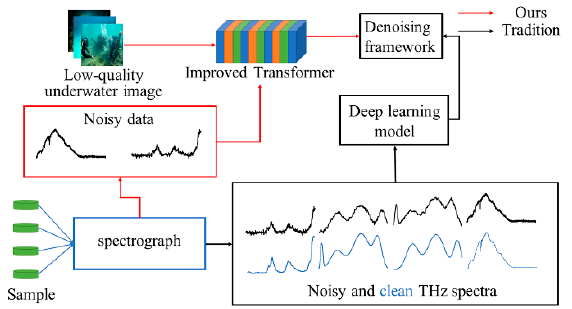
Figure 1. Comparison of the traditional and proposed methods.